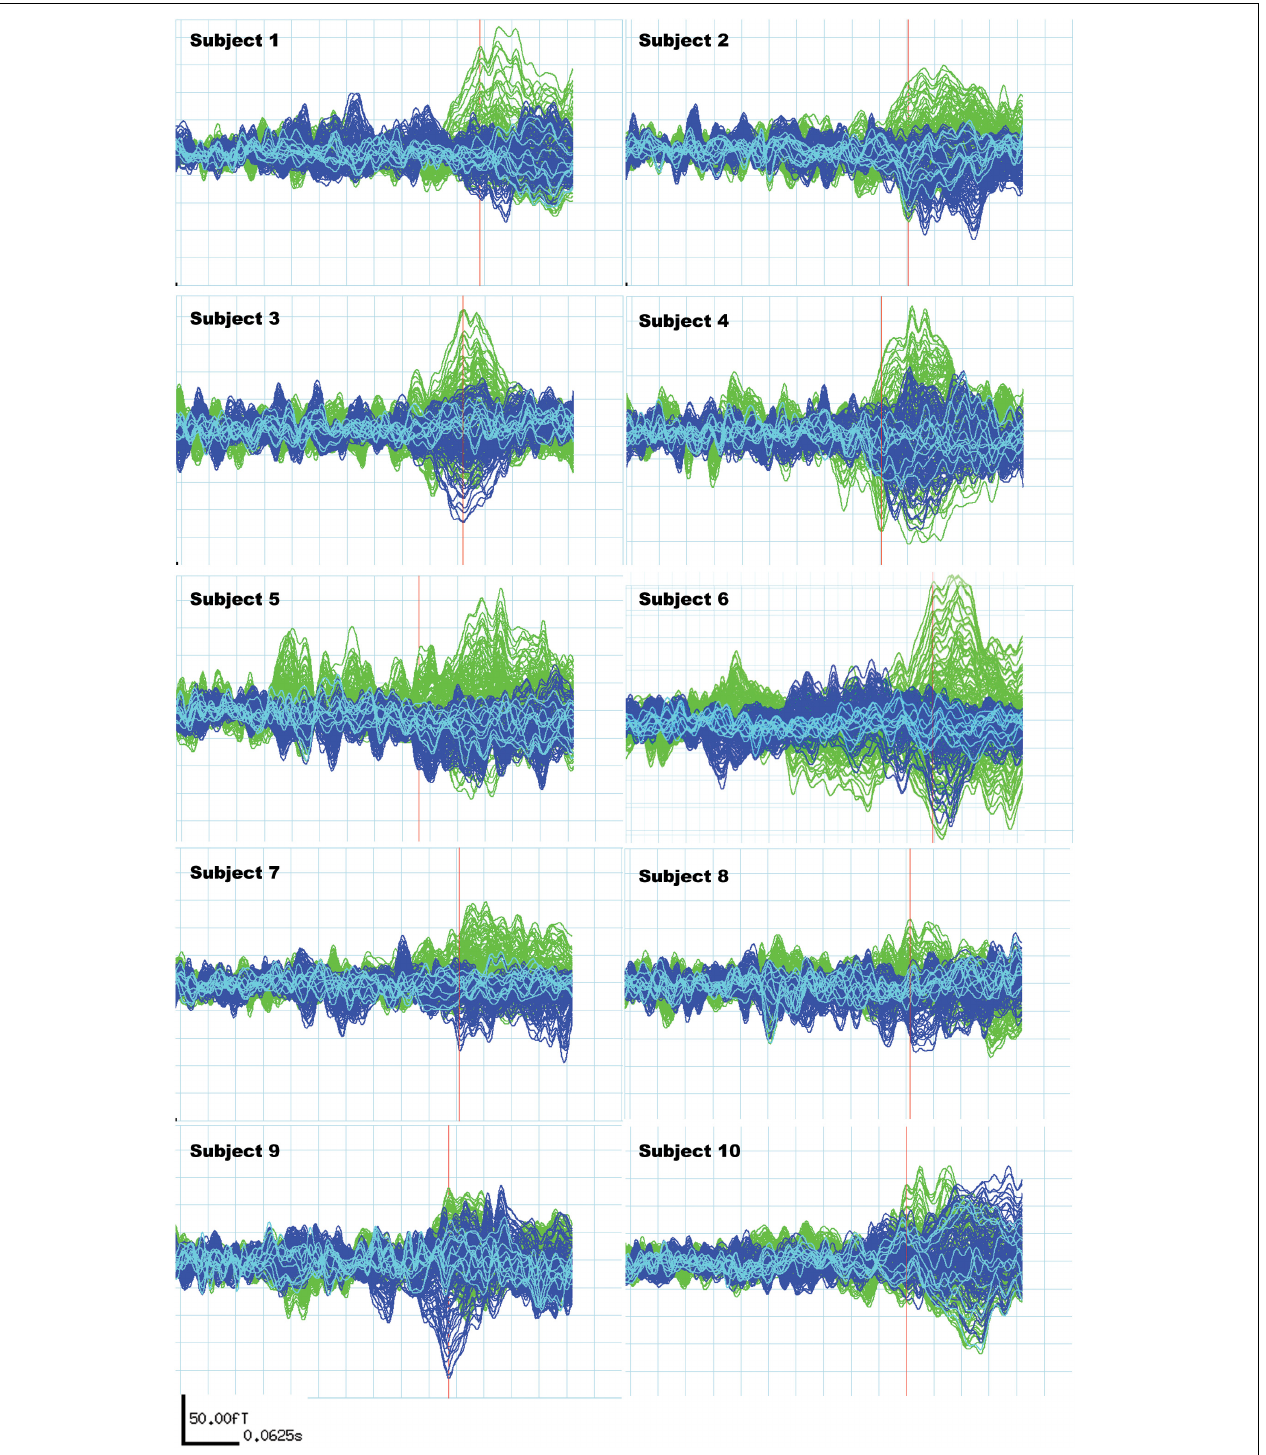
FIGURE 2 | Individual N400m signals of all 10 subjects. These signals are subtractions of the “unrelated” condition average from the “related” condition average to reflect the difference in N400m response only. The green signals represent activities recorded from the left hemisphere and the blue signals represent activities recorded from the right hemisphere. Light blue signals derive from midline sensors. The red bar locates the time point used to measure N400m latency and amplitude, which is the first peak within the N400m time window (300–500 ms) with a signal-to-noise ratio higher than 1.5 for each subject.